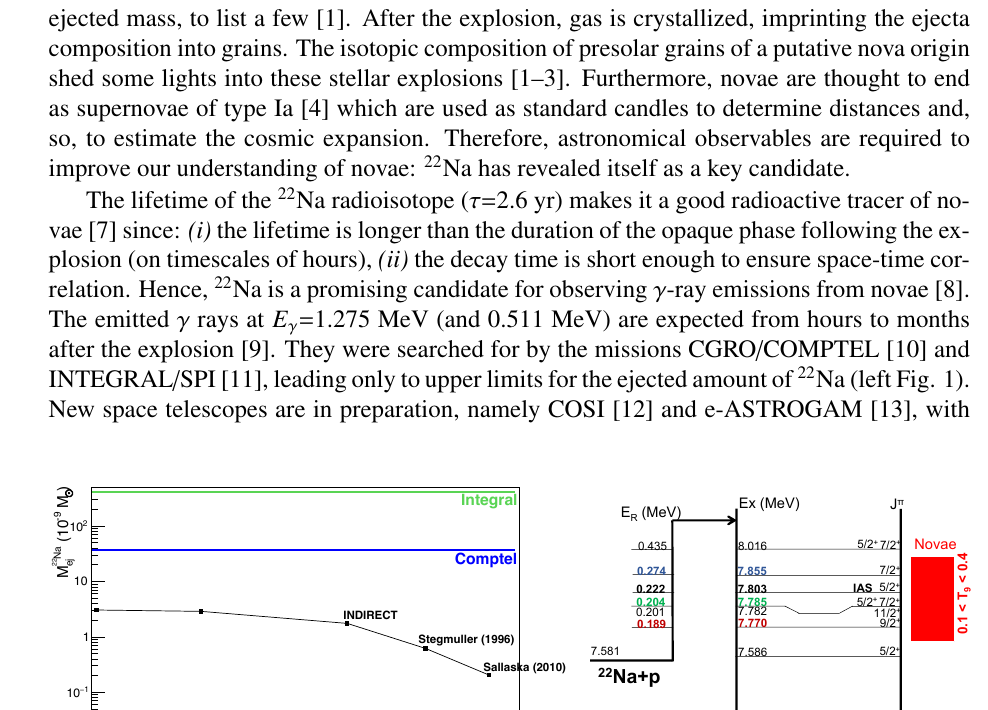
sensitivities 20 times higher than INTEGRAL. The radioisotope 22 Na can be also measured, indirectly, by the over-abundance of the daughter nucleus 22 Ne in presolar grains. Neon noble gas is not expected to easily condense into dust grains and, so, the presence of 22 Ne implies in-situ β + decays of 22 Na. A 22 Ne excess was observed [14]. Therefore, it is critical to well quantify 22 Na nucleosynthesis in